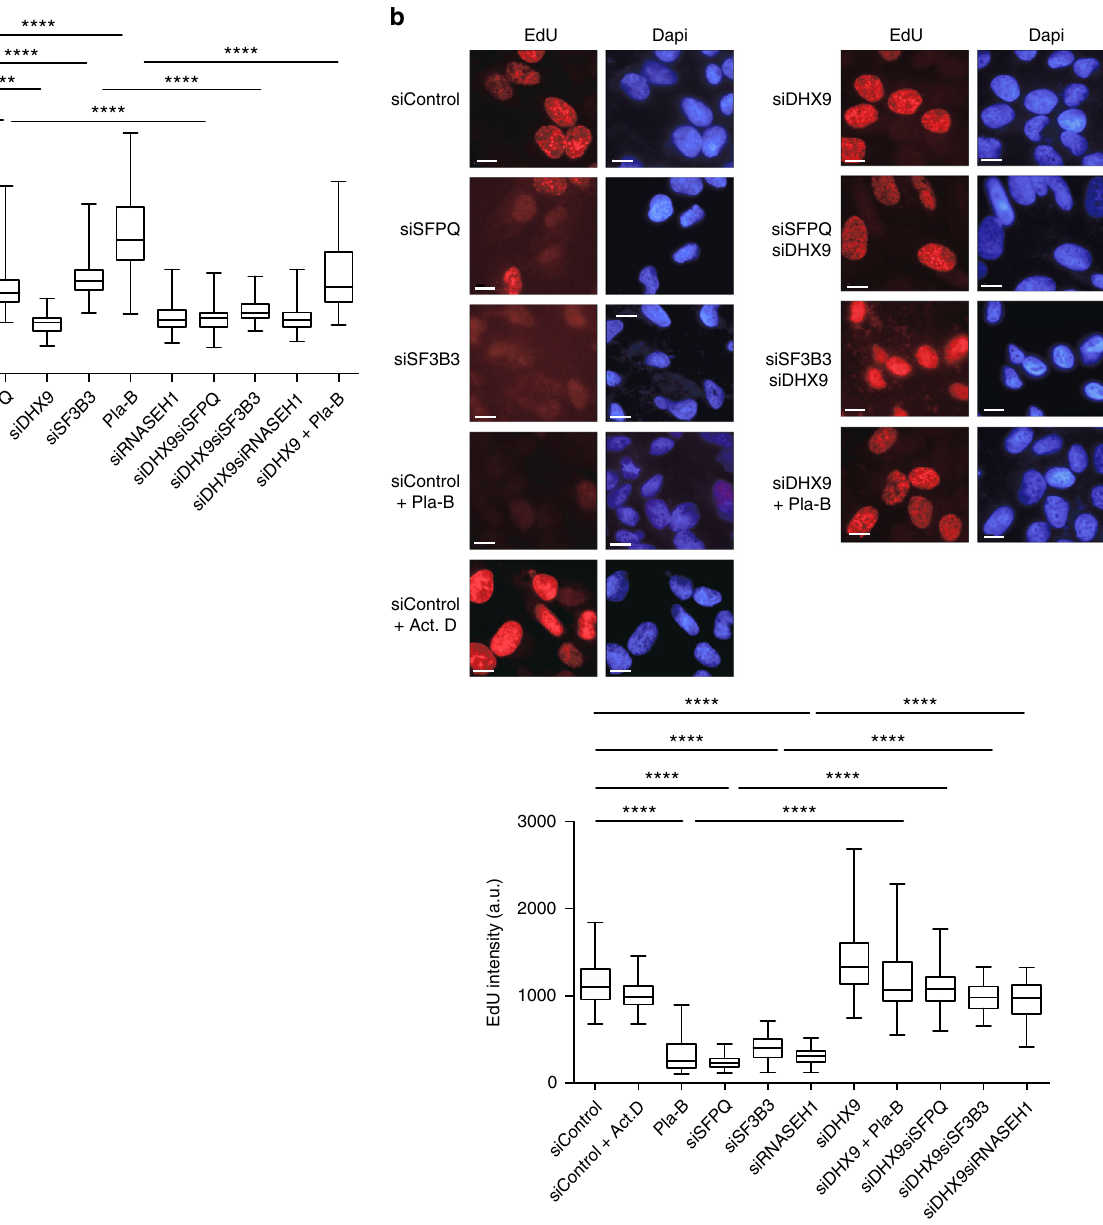
Fig. 4 Defects in RNA splicing cause increased R-loops. a Inhibition of RNA splicing leads to elevated levels of RNA – DNA hybrids that are suppressed by knockdown of DHX9. Cells were transfected with siRNAs targeted to the indicated genes, individually and in combination. Where indicated, cells were treated with Pla-B (5 μ M) for 2 h to inhibit splicing. b Incorporation of EdU into DNA 72 h after knockdown of the indicated genes. Where indicated, cells were treated with Pla-B (5 μ m) or Actinomycin D (0.5 μ g/ml). All scale bars represent 10 μ m. Graphical data from n > 90 cells are presented.